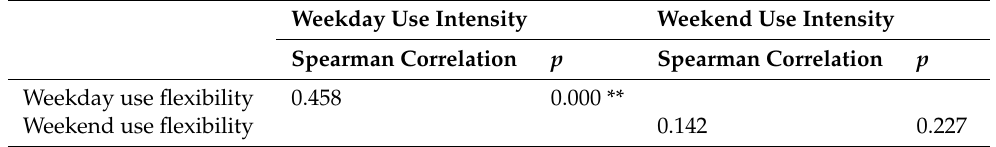
Table 5. Bivariate correlation between the use flexibility and use intensity of the sampled pocket parks ( n =